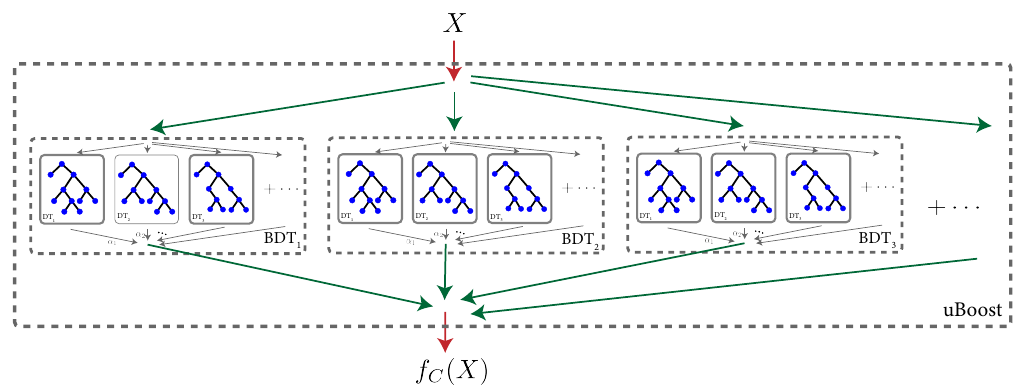
Figure 8: The network architecture used in the uBoost algorithm. Each BDT has the same layout as those in Fig. 2, and is tasked with keeping the background uniform at a given target signal efficiency. We use 20 BDTs to cover the entire efficiency range, and results are interpolated between target efficiencies to keep the background uniform over the whole efficiency range. The Gini index is used to measure the quality of a split, and the best split is taken when creating new